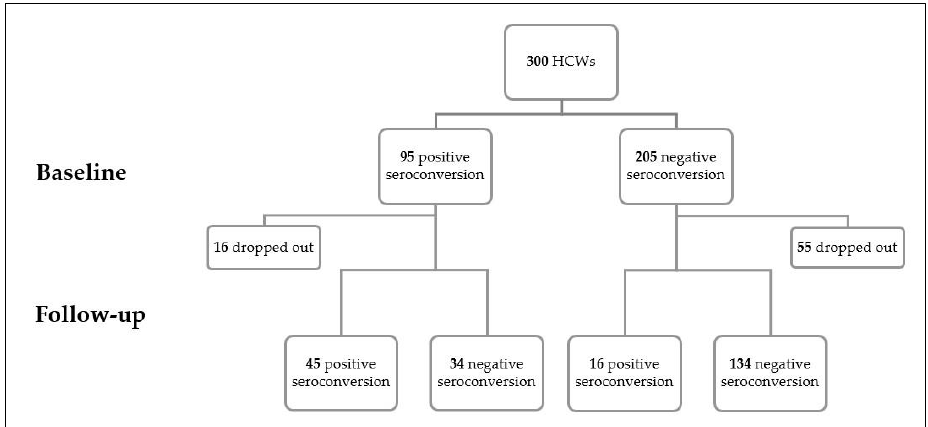
Figure 2. The positive and negative seroconversion at baseline and follow-up. At baseline and follow-up, the seroconversion rate did not differ between the two groups of direct and indirect contact ( p -value = 0.1 and 0.2, respectively) (Table 2). A Wilcoxon test were used to compare changes in IgM and IgG serum levels at baseline and follow-up time. The mean of GMT for anti-SARS-CoV-2 IgM decreases from 0.37